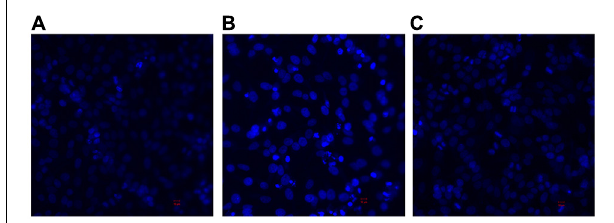
FIGURE 7 | Appearances of DAPI stained-nuclei of HeLa cells after treatment with (A) Medium alone (B) 3O-C12-HSL (50 µ M) and (C) mixture of 3O-C12-HSL (50 µ M) and HuscFv-F19 (2 µ M) for 18 h (original magnification 200 ×